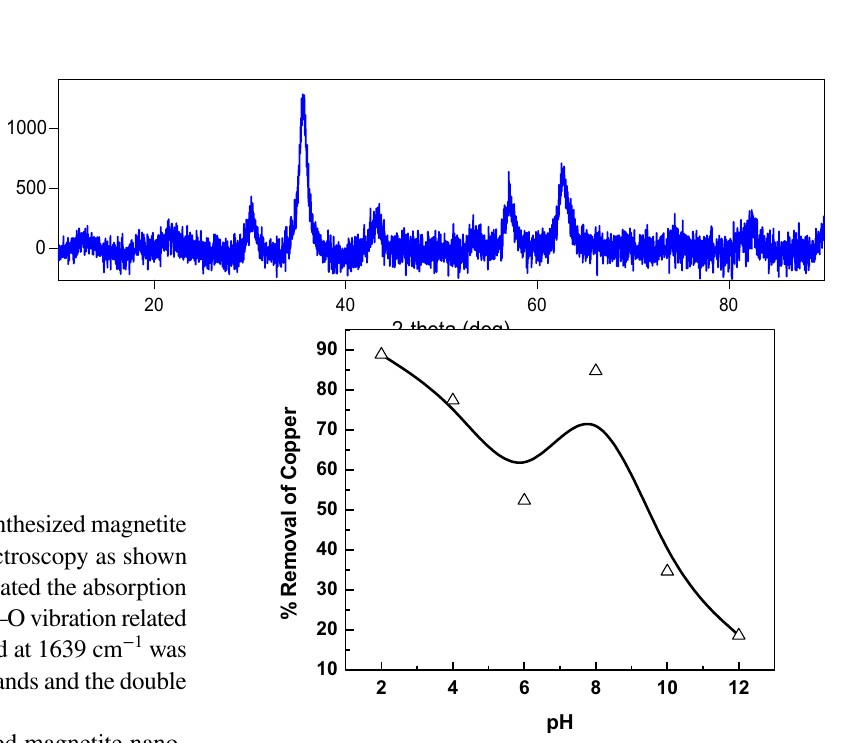
Fig. 3 FTIR Spectra of magnetite nanoparticles